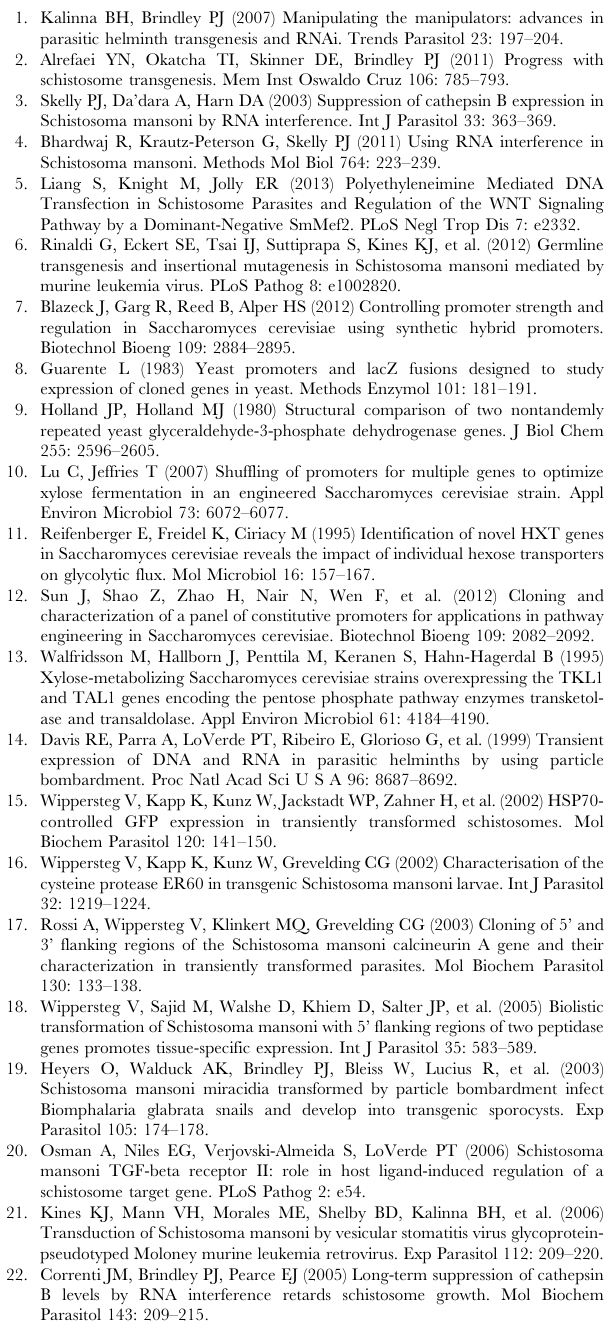
Table S1 Primer sequences used to amplify different promoters of schistosome genes and viral promoter. Table S2 Gene names and primer sequences used for quanti- tative PCR